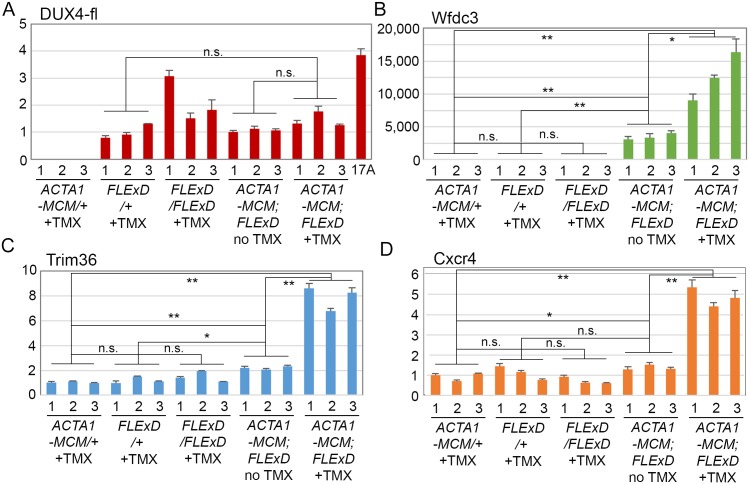
TMX induction leads to DUX4-FL target gene expression in skeletal muscle of ACTA1-MCM;FLExDUX4 mice.Gastrocnemius muscles from 13-week-old mice were assayed 9 days post-IP injection with TMX, as indicated, and relative mRNA expression levels for DUX4-fl and three DUX4-FL target genes were determined. Each of the 3 individual mice per group (1, 2, 3) are shown. (A) DUX4-fl mRNA expression assayed by qRT-PCR does not significantly change between groups, despite increased protein expression (Fig 11). (B) Wfdc3 mRNA expression is upregulated in both double transgenic groups compared with FLExDUX4 alone; however, TMX treatment significantly induces Wfdc3 expression in ACTA1-MCM;FLExDUX4 compared with the untreated control ACTA1-MCM;FLExDUX4 mice. In contrast, (C) Trim36 and (D) Cxcr4 mRNA expression are relatively constant and only upregulated in response to TMX induction in ACTA1-MCM;FLExDUX4 mice. Significance was calculated using Welch’s t-test; n.s. = not significant (p>0.05), * = p<0.05, ** = p<0.005.